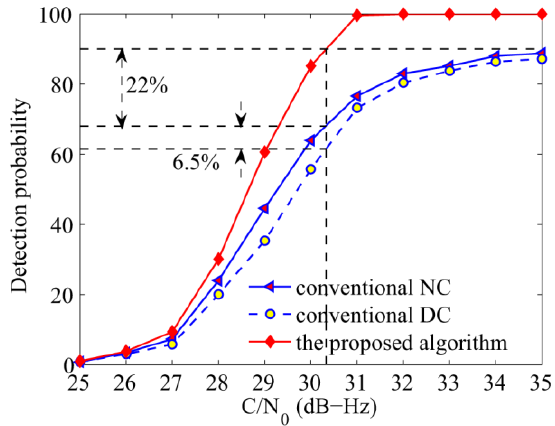
Figure 12. Detection probabilities of the NC, DC, and the proposed algorithms against C/N 0 .